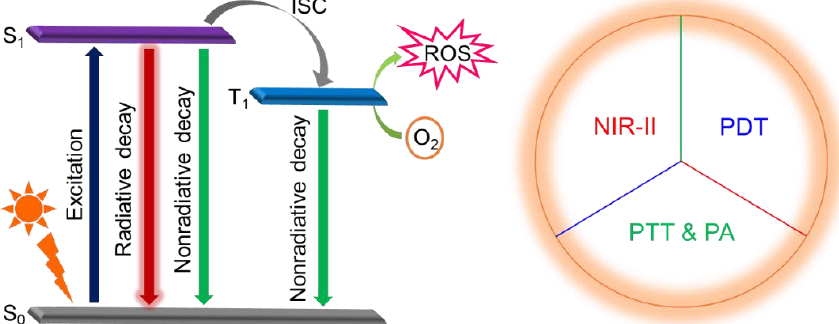
Scheme 1. Schematic illustration of Jablonski diagram of NIR-II AIEgens with multifunctional prop- erties for phototheranostic